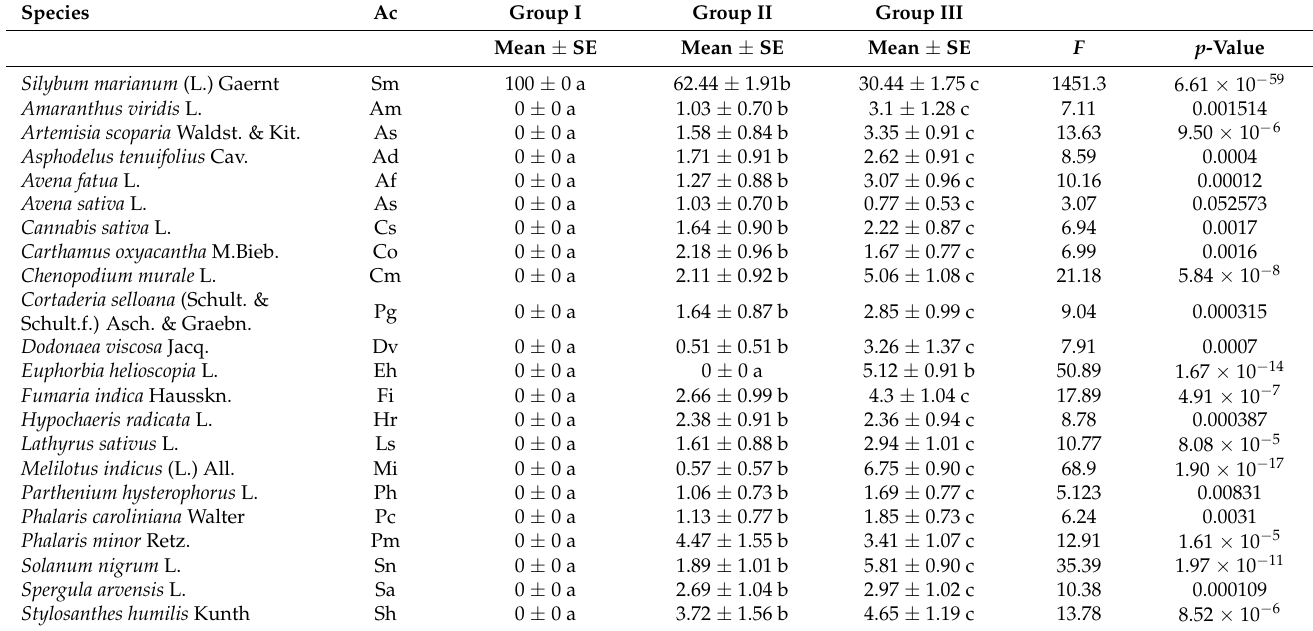
Table 2. Importance value index of Silybum marianum and associated species found in the three groups separated by cluster analysis.